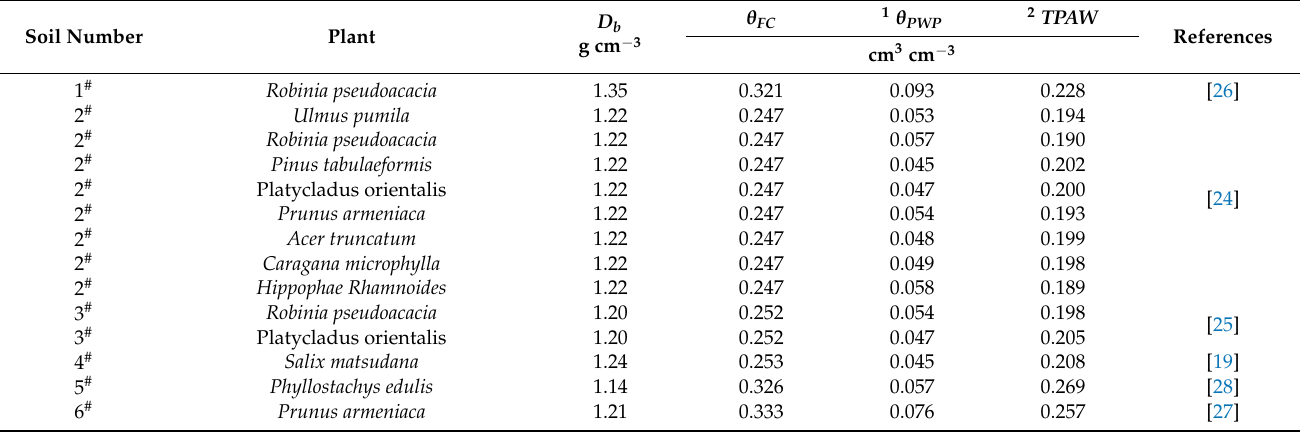
Table 1. Soil bulk density ( D b ), field capacity ( θ FC ), permanent wilting point ( θ PWP ), empirical estimate of capillary break water ( θ CB-E ), and total plant available water ( TPAW ) of six soils and tree types from six published